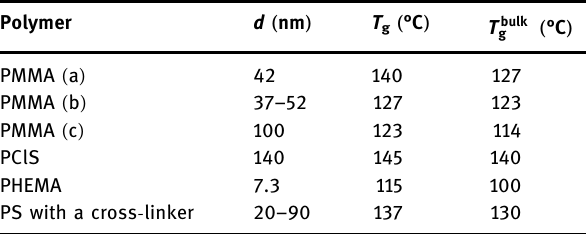
Table 2: Average shell thickness d and the glass transition temperature T g of the shells